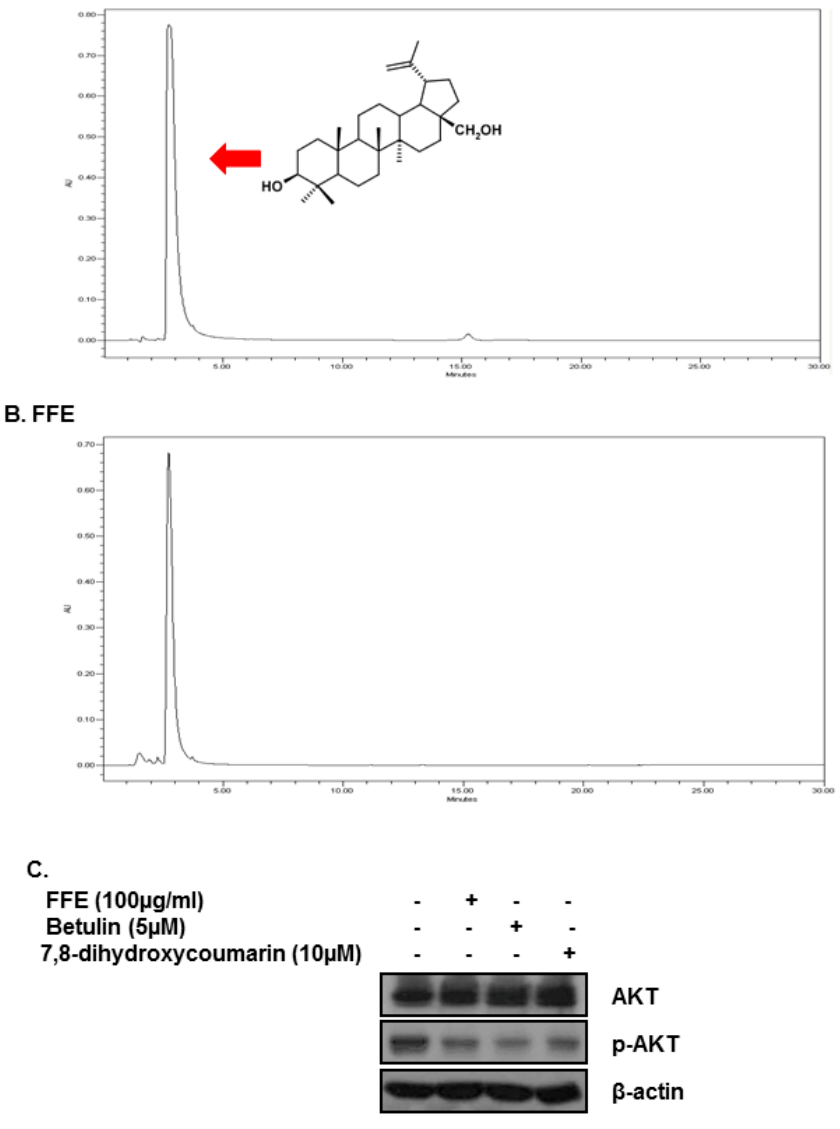
Figure 6. Effect of main compounds of FFE betulin and daphnetin on p-AKT and AKT in MDA-MB- 231 cells. ( A ) HPLC chromatograms of betulin. ( B ) FFE. ( C ) Inhibitory effect of betulin and daphnetin on p-AKT expression in MDA-MB-231